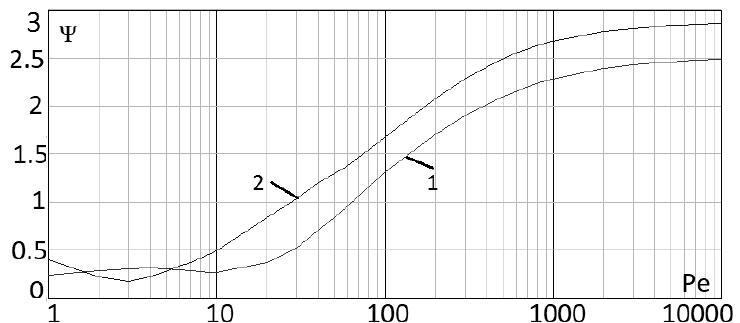
Figure 12. Error functions Ψ of the numerical solution of the test problem IV in the norm L 1 , depending on values of grid Péclet number: 1—the difference scheme (47), 2—the Upwind Leapfrog difference scheme with TVD-limiters.